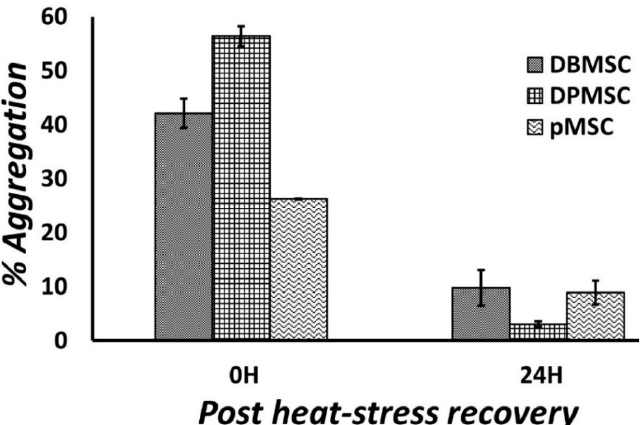
Figure 2. Estimation of protein aggregation in heat-stress models of DBMSCs, DPMSCs, and pMSCs. Increase in aggregation was measured as percentage change in fluorescence as compared to total proteome of cells grown at 37 °C. All the three cell types exhibited the highest presence of aggregates immediately after heat stress, i.e., recovery time 0H confirming existence of proteotoxic stress. We measured the impact of heat stress on cell viability and proliferation using the xCELLigence real-time cell analysis (RTCA) system. The cell behavior was monitored over a period 72 h in control cells grown at 37 ◦ C and in cells exposed to heat at 44 ◦ C for 1, 2, and 3 h in the case of DBMSCs, DPMSCs and 1 and 2 h in case of pMSCs. The calculated Cell Index (CI) values indicate a decrease in proliferation (Figure 3, Table 1). In the case of DBMSCs and DPMSCs, a 3-h exposure at 44 ◦ C leads to a statistically significant ( p < 0.05) reduction in cell proliferation, which is observable even at 24 h post-heat stress. This decreased cellular proliferation points towards the persistence of cellular stress, potentially an active heat-shock